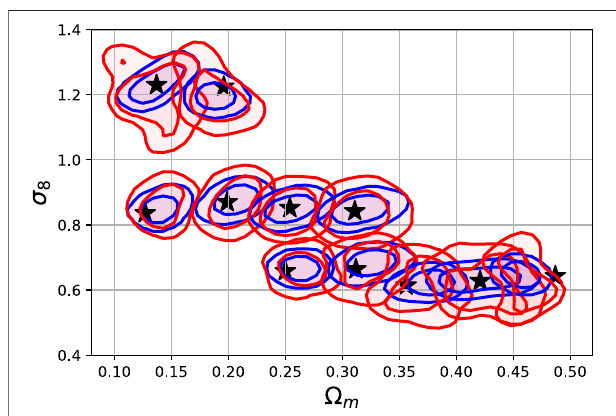
FIGURE9| Predictions ofaregressor CNN trained topredict the Ω m , σ 8 from input images. The details of this experiment are described in Section 4 andthenetworkarchitecturein TableA1 in AppedixA .Thecontoursencircle the 68 and 95% samples for the N-body maps (blue) and GAN- generated maps from the test set. The black stars show the true values of the test set parameters.